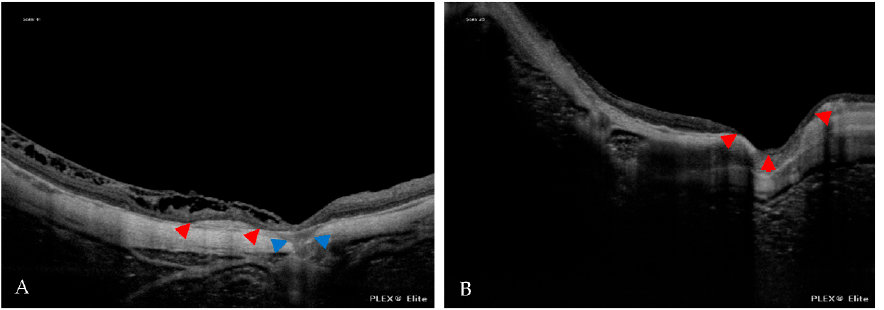
Figure 10. Multimodal images of a macular pit with scleral dehiscence. ( A ) In a fundus photograph, the red circle indicates a grayish and black lesion that is correlated with the pit. ( B ) In an OCT reflectance image, the red circle indicates an area of hyporeflectance correlated with the pit. ( C ) In an OCT scan, the blue arrowheads indicate the pit with scleral dehiscence.